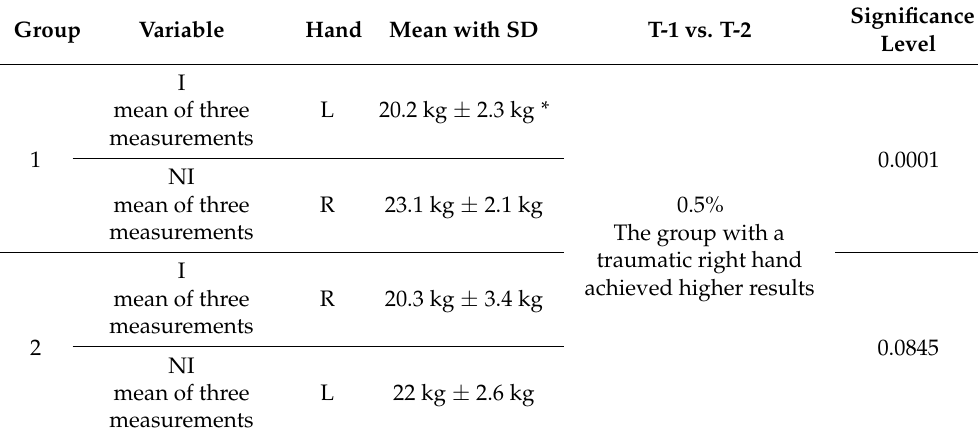
Table 9. Comparison of results for the mean value of three grip strength measurements.